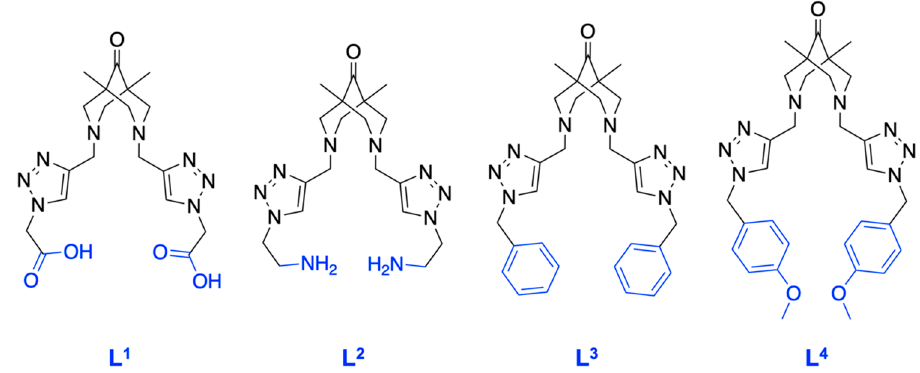
Figure 2. Structures of the bispidine-based bis-azole ligands used in the work. L 1 · 2TFA–2,2 (cid:48) - (((1,5-dimethyl-9-oxo-3,7-diazabicyclo[3.3.1]nonane-3,7-diyl)bis(methylene))bis(1H-1,2,3-triazole- 4,1-diyl))diacetic acid. L 2 · 3.3TFA–3,7-bis((1-(2-aminoethyl)-1H-1,2,3-triazol-4-yl)methyl)-1,5- dimethyl-3,7-diazabicyclo-[3.3.1]nonan-9-one. L 3 –3,7-bis((1-benzyl-1H-1,2,3-triazol-4-yl)methyl)- 1,5-dimethyl-3,7-diazabicyclo[3.3.1]nonan-9-one. L 4 –3,7-bis((1-(4-methoxybenzyl)-1H-1,2,3-triazol-